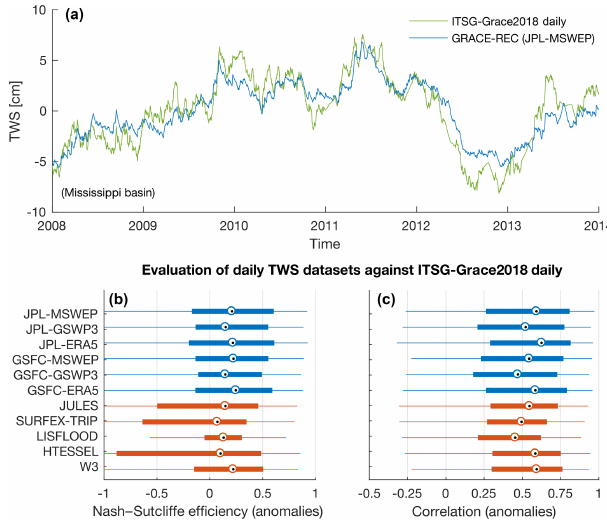
Figure 10. (a) Comparison between the GRACE-REC daily TWS reconstruction (JPL-MSWEP dataset) and the daily GRACE ITSG- Grace2018 solution for the Mississippi basin (focused over the pe- riod 2008–2014 to improve readability of the high-frequency fluc- tuations). (b–c) Global-area-weighted box plots of the performance metrics of the daily TWS datasets when compared with ITSG- Grace2018 at a spatial resolution of 5 ◦ . Note that some WRR2 mod- els are not included because not all water storage variables were available to us at daily frequency. Greenland and Antarctica are ex-